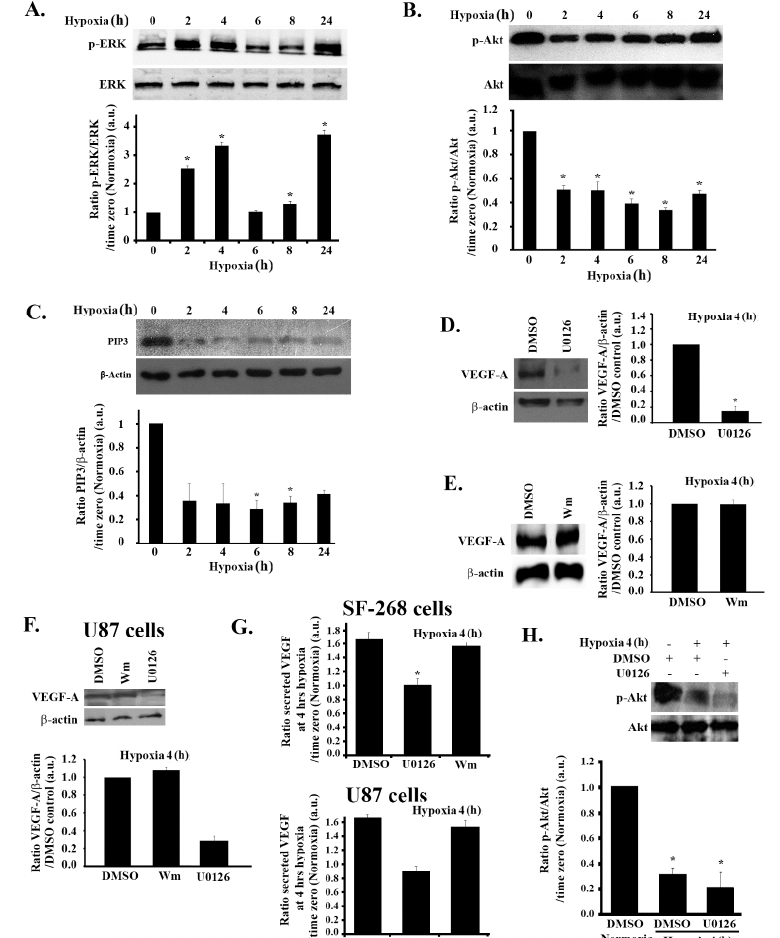
Figure 2. Hypoxia-induced increase in VEGF expression is ERK-dependent but PI3K-independent in glioblastoma cells. (A/B/C) SF-268 cells were subjected to hypoxia using cobalt(II) chloride hexahydrate (CoCl 2 ) for the indicated time. Cells were then lysed, and the lysates were blotted for p-ERK and ERK ( A ) and p-Akt and Akt ( B ), as well as PIP 3 and β -actin for loading control ( C ). The graphs in each panel are densitometric analysis of the Western blots using Image J. Values are normalized to the loading control (ERK, Akt, and β -actin for p-ERK, p-Akt, and PIP 3 , respectively) and expressed as fold change compared to time zero (normoxia). (D/E) SF-268 cells were treated with 50 µM U0126 (with DMSO as a carrier) for 24 h ( D ) or with wortmannin 100 nM (Wm) (with DMSO as a carrier) for 4 h ( E ) or with DMSO as a control. Cells were then subjected to 4 h hypoxia and lysed, and cell lysates were blotted for VEGF-A or β -actin for loading control. The graphs are quantitations for the VEGF bands in ( D / E ) normalized to actin and expressed as fold change compared to control (DMSO). ( F ) U87 cells were treated with 50 µ M U0126 for 24 h or with wortmannin 100 nM (Wm) for 4 h (with DMSO as a carrier). Cells were then subjected to 4 h hypoxia and lysed, and cell lysates were blotted for VEGF-A or β -actin for loading control. The graphs are quantitations for the VEGF bands in ( F ) normalized to actin and expressed as fold change compared to control (DMSO). ( G ) ELISA for supernatants from SF-268 cells (upper graph) or U87 cells (lower graph), treated with U0126 or wortmannin or DMSO alone and then kept in normoxia or subjected to 4 h hypoxia. Supernatants were collected and measured for VEGF-A secretion according to the manufacturer’s guidelines. Values are expressed as fold change at every treatment to normoxia. ( H ) ( + indicates addition of the treatment) SF-268 cells were treated with DMSO or with 50 µ M U0126 for 24 h, subjected to hypoxia for 4 h. Cells were then lysed, and the lysates were blotted for p-Akt and Akt. The graph is a quantitation of the gels. Values are normalized to Akt and expressed as fold change compared to control (normoxia + DMSO alone). The data are means ± SEM from three di ff erent experiments; * p < 0.05 indicates statistically significant di ff